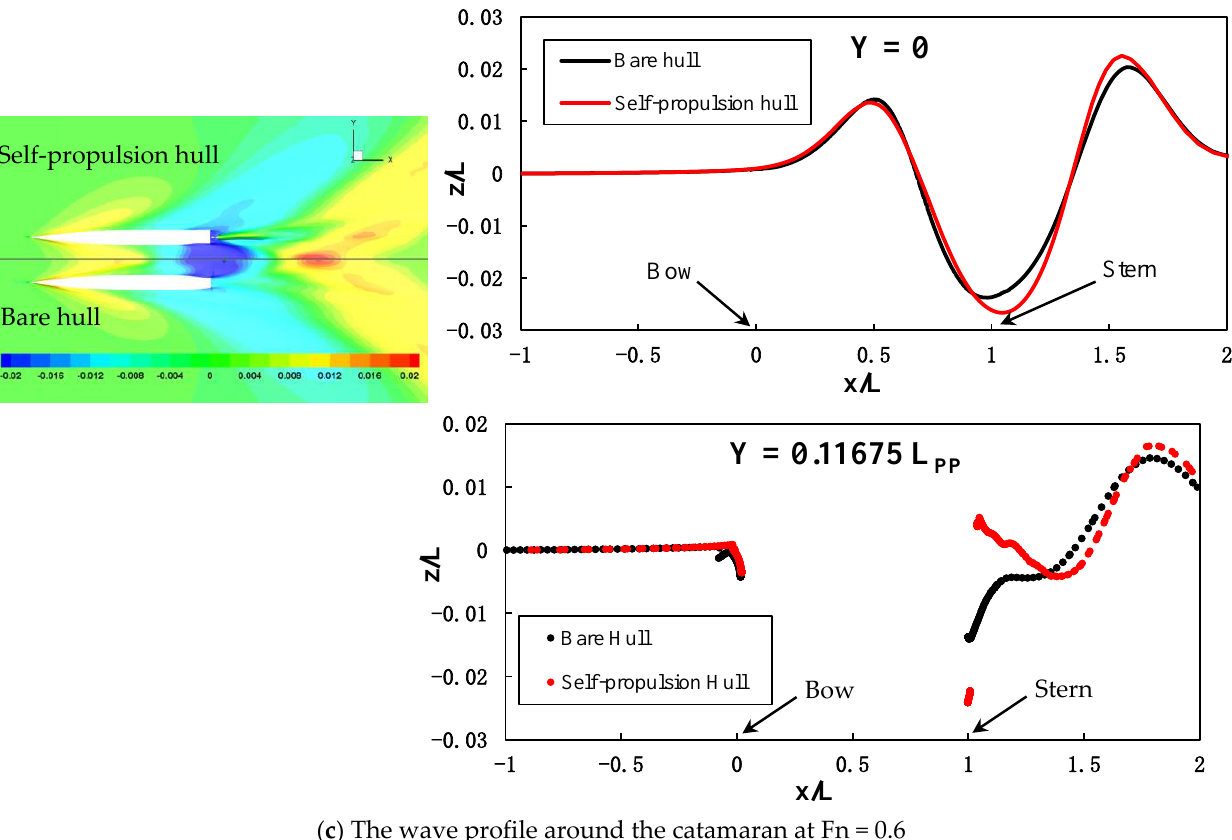
( c ) The wave profile around the catamaran at Fn = 0.6 Figure 14. Wave profile comparison between bare hull and self-propulsion hull. Figure 14. Wave profile comparison between bare hull and self-propulsion hull. Figure 14. Wave profile comparison between bare hull and self-propulsion hull.